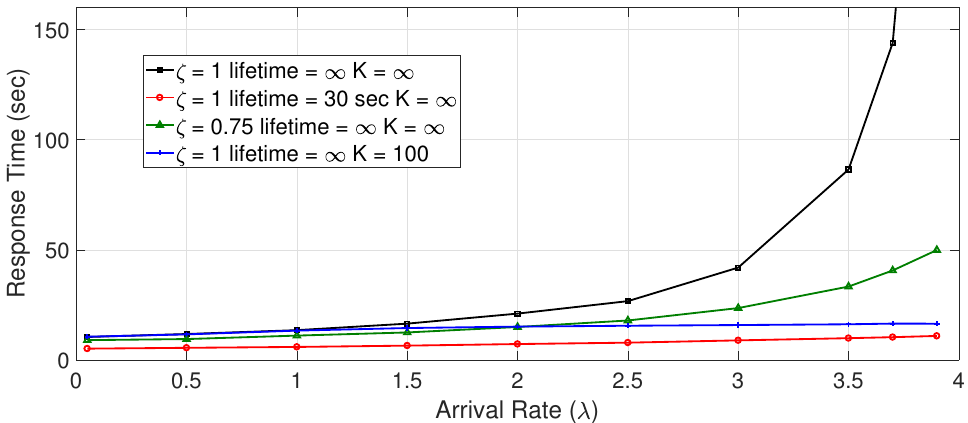
Figure 6. Response time for various ON/OFF model parameters.